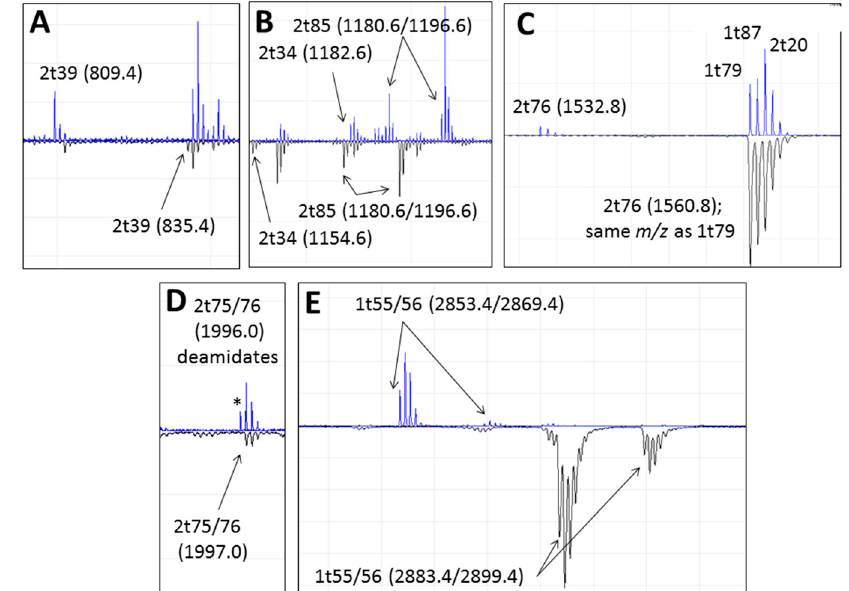
Figure 3. Sections of the MALDI fingerprints that highlight homologous markers between Bos ( top ) and Ovis ( bottom ) tryptic collagen peptides showing: ( A ) 2t39; ( B ) 2t34 and 2t85; ( C ) 2t76 (noting that the Ovis marker is at the same m / z as other collagen peptides); ( D ) 2t75/76 (* note that the Bos form of 2t75, HGNR, includes an amino acid susceptible to deamidation that could be mistaken as the homologous marker in Ovis and Sus ); and ( E ) 1t55/56 (“/” indicates missed cleavage site, i.e. , the presence of an internal K or R residue).